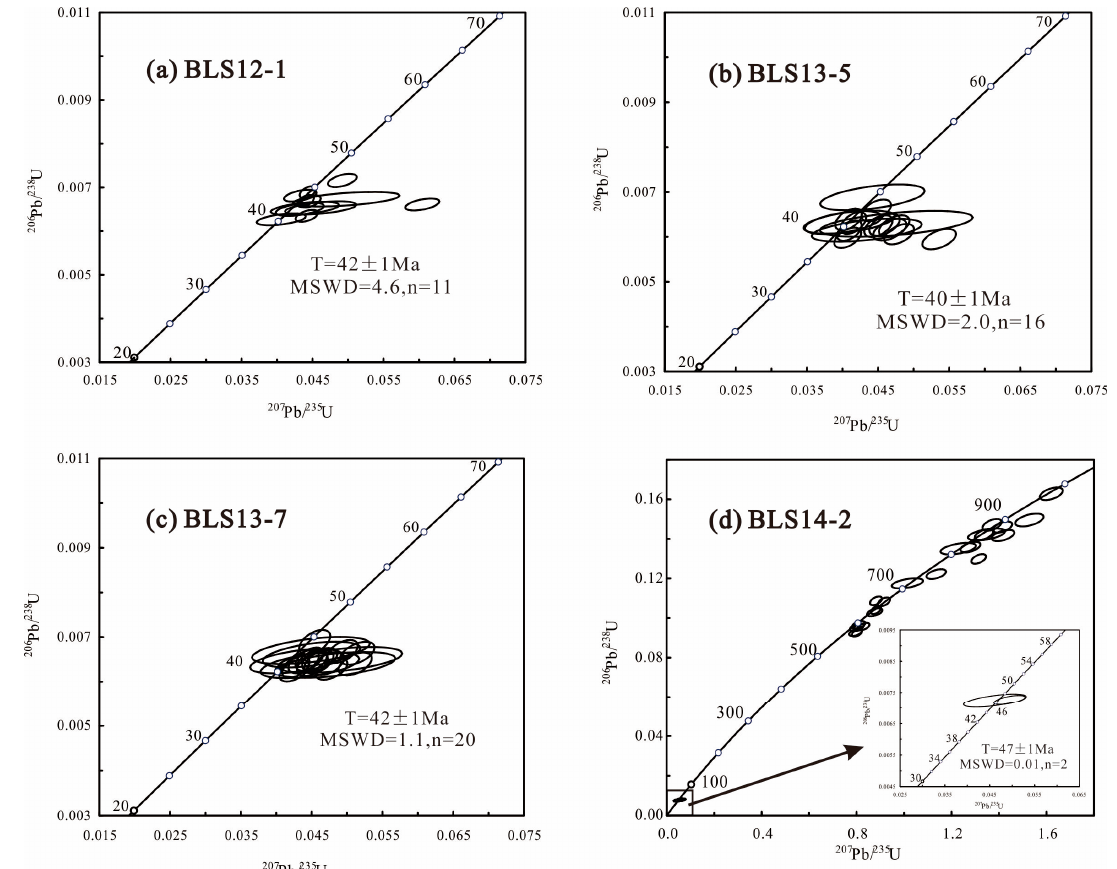
Figure 5. ( a – d ) U–Pb concordia diagrams for zircons from samples of Cenozoic mafic rocks in the Qianjiadian area.